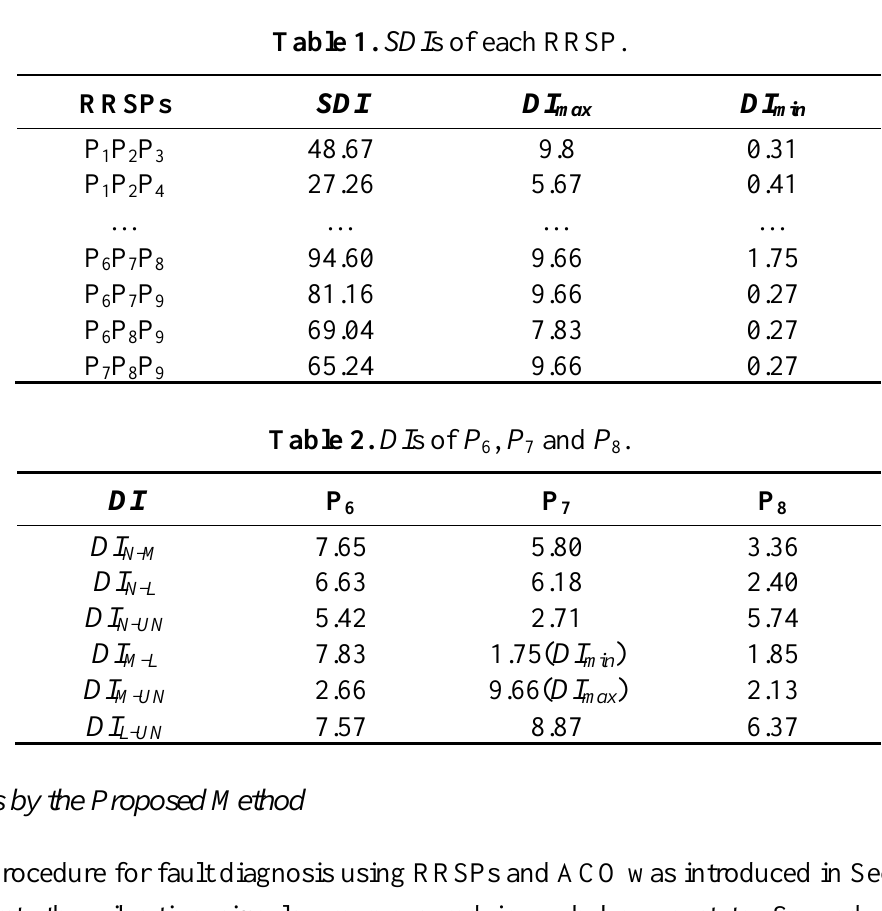
Table 1. SDI s of each RRSP.